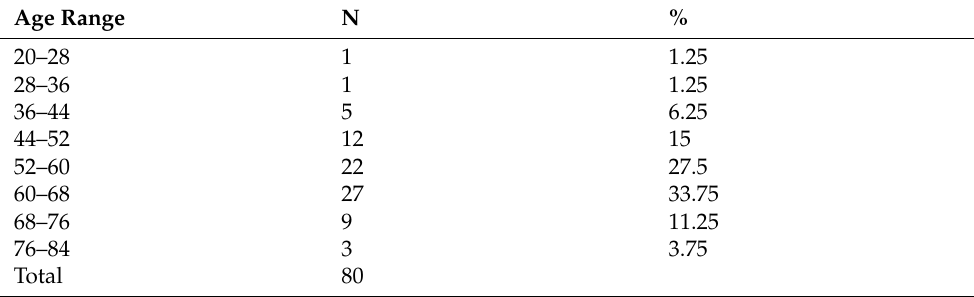
Table 1. Age expressed in years on the day of the intervention.